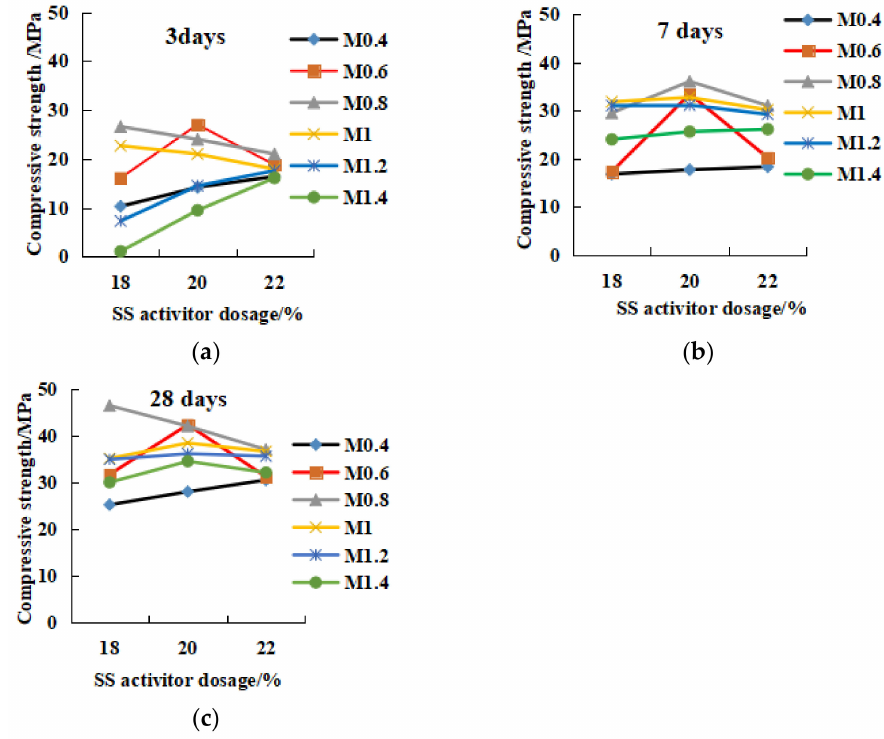
Figure 10. The relationship between the dosage of SS activator and the compressive strength. ( a ) 3 days, ( b ) 7 days, ( c ) 28